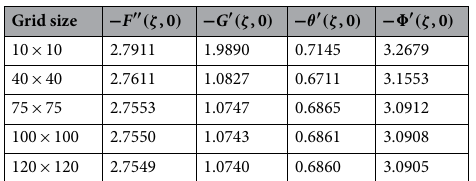
Table 1. Study of Grid independence for different grid sizes at ζ